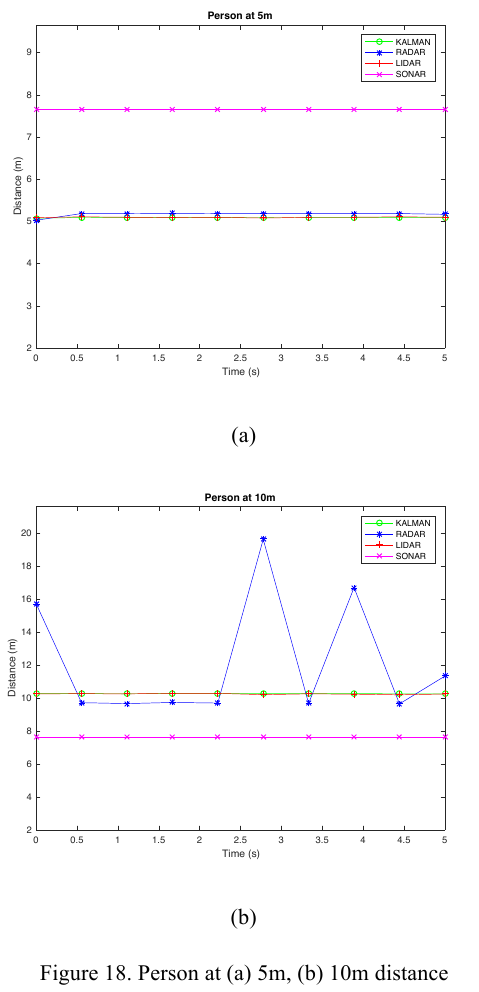
Figure 18. Person at (a) 5m, (b) 10m distance 4.2.6 Vegetation: Vegetation (Figure 19) can be a tough obstacle